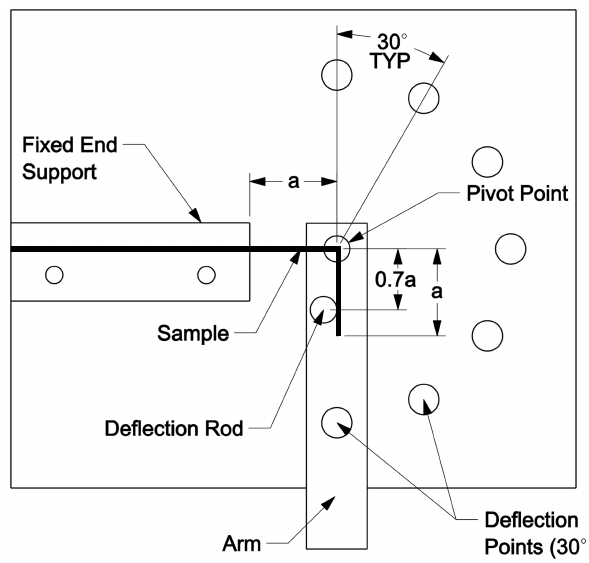
Figure 4. Top view of the test fixture. The sample can be seen in the center, clasped in the fixed end support.